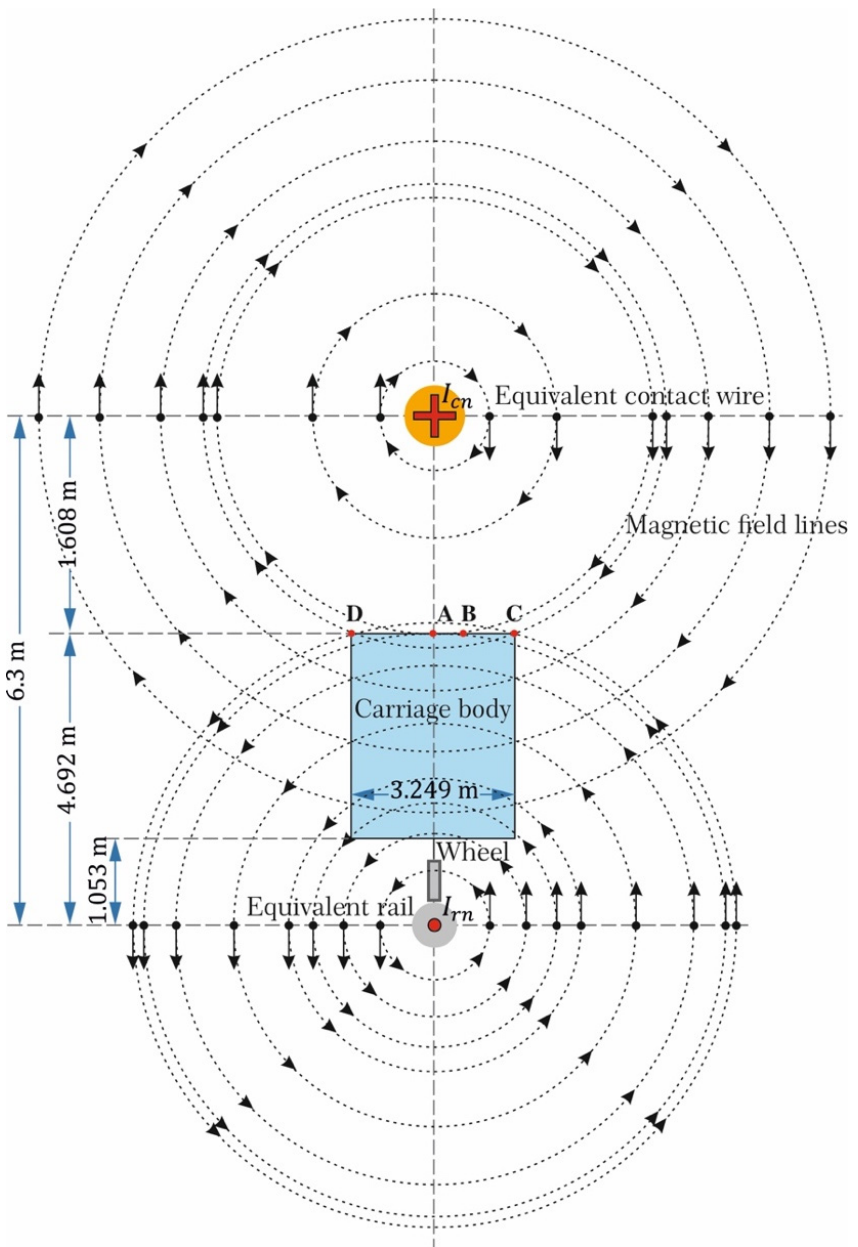
Figure 2. Schematic representation of magnetic field lines created by traction current flowing in the equivalent contact wire and rail propagating in the space of the AC inter-substation zone and penetrating the carriage body.